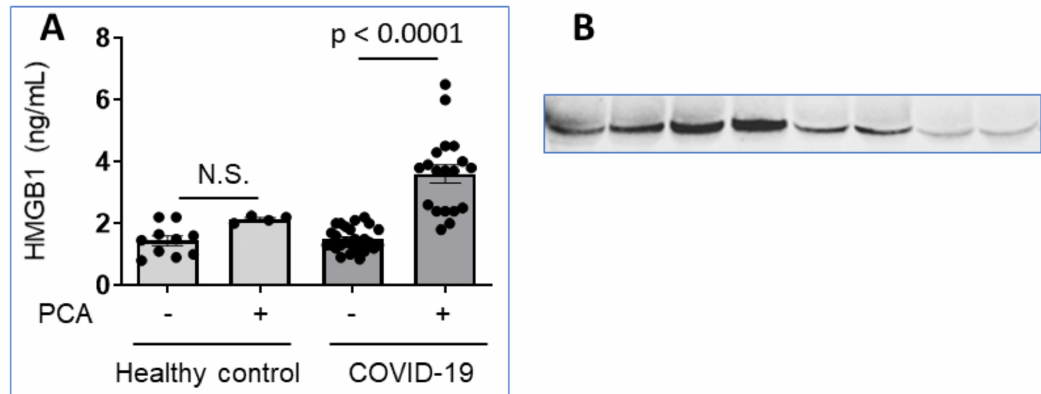
Figure 9. Plasma HMGB1 levels are increased in patients with severe COVID-19. ( A ) Multiple plasma samples from COVID-19 patients (27 samples from 9 patients) and healthy controls (14 samples from 4 healthy controls) were analyzed in HMGB1 ELISA (IBL International GmbH, Germany). The samples were either pretreated by perchloric acid (PCA) or not [96]. ( B ) Plasma samples from two COVID-19 patients and two healthy controls were subjected to SDS polyacrylamide gel electrophoresis in reducing conditions and probed with a monoclonal anti-HMGB1 antibody. Lanes 1-4 shows plasma samples from day 0, 2, 3, 4 from the admission of a patient with lethal Covid-19 infection; lanes 5–6 represent samples from a severely ill COVID-19 patient on day 0 and 1 from admission, while lanes 7–8 demonstrate results in two healthy